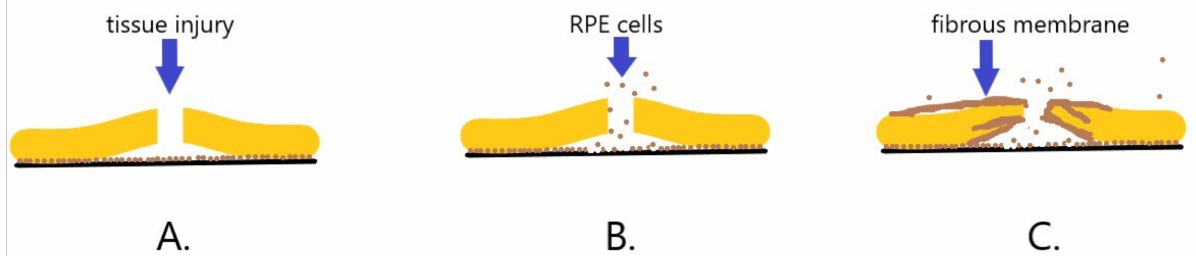
Figure 4. Diagram of the development of proliferative vitreoretinopathy (PVR). ( A ). As a result of tissue injury and retinal disruption, the neurosensory layer of the retina separates from the retinal pigment epithelium (RPE). ( B ). RPE cells migrate through the retinal break towards the vitreous chamber. ( C ). RPE cells transdifferentiate to fibroblasts and then begin to proliferate and produce collagen, forming fibrous membranes that cover and overgrow the